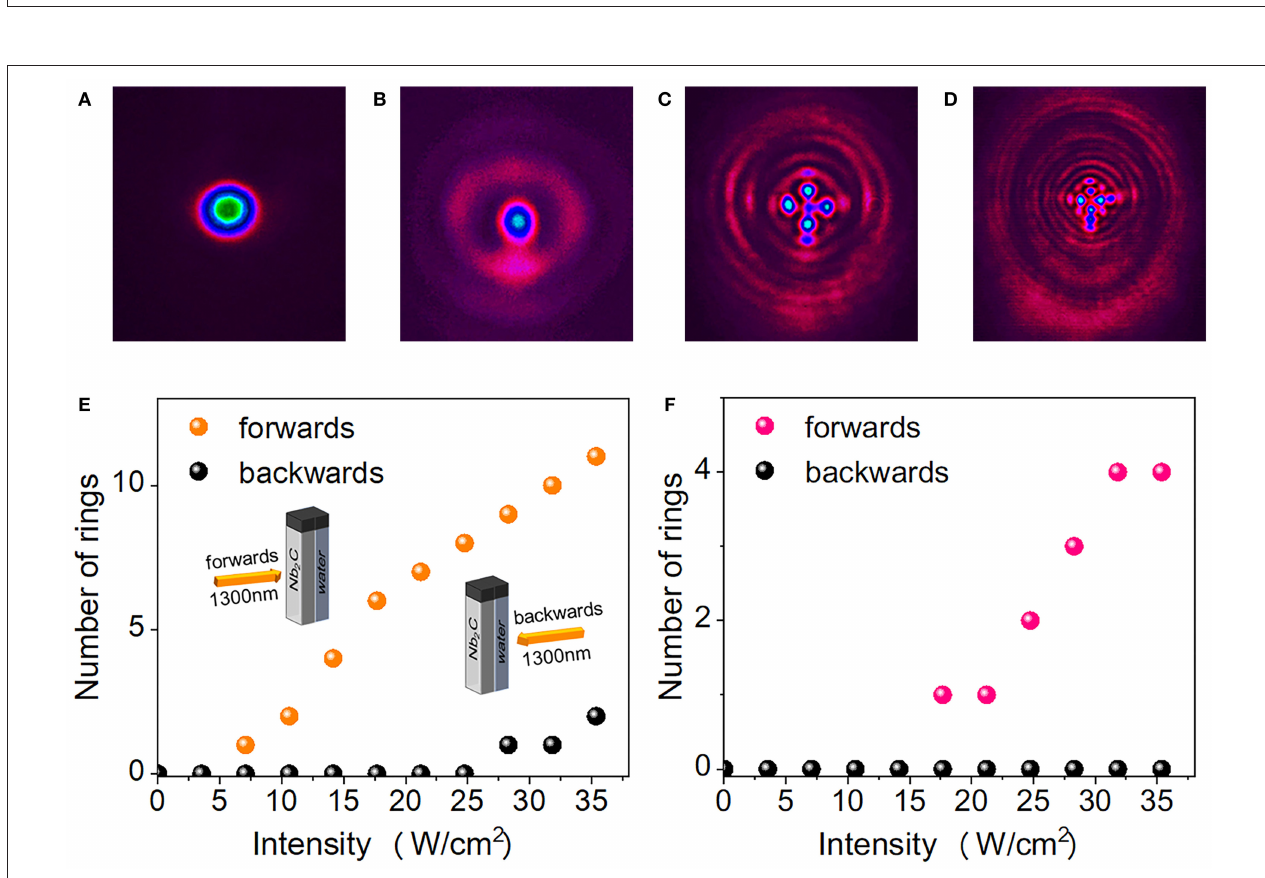
FIGURE 5 | (A–D) SSPM patterns (acquired at the forward advancement of the laser beam) of a Nb 2 C/water hybrid structure at a wavelength of 1,300nm and laser beam intensities of (A) 3.5 W/cm 2 , (B) 10.6 W/cm 2 , (C) 21.2 W/cm 2 , (D) 31.8 W/cm 2 . (E,F) Number of diffraction rings vs. laser beam intensity at (E) 1,300nm and (F) 1,550nm at the forward (backward) movement of a laser beam through the hybrid structure. The inserted images explain the beam incidence direction.